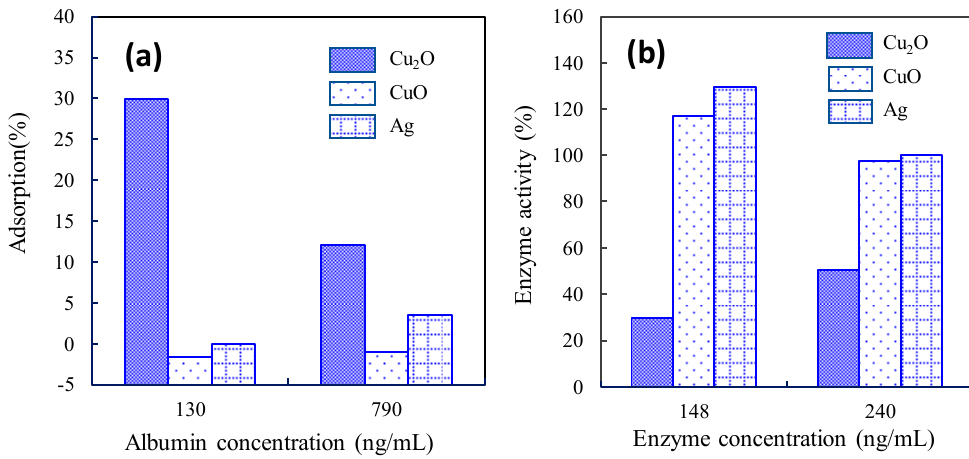
Figure 3. ( a ) Adsorption properties of bovine serum albumin (BSA) onto Cu 2 O, CuO, and Ag after 8 h exposure. Panel ( b ) shows enzyme activities of these materials after 1 h exposure [34]. These data are based on average of triplicate measurements.